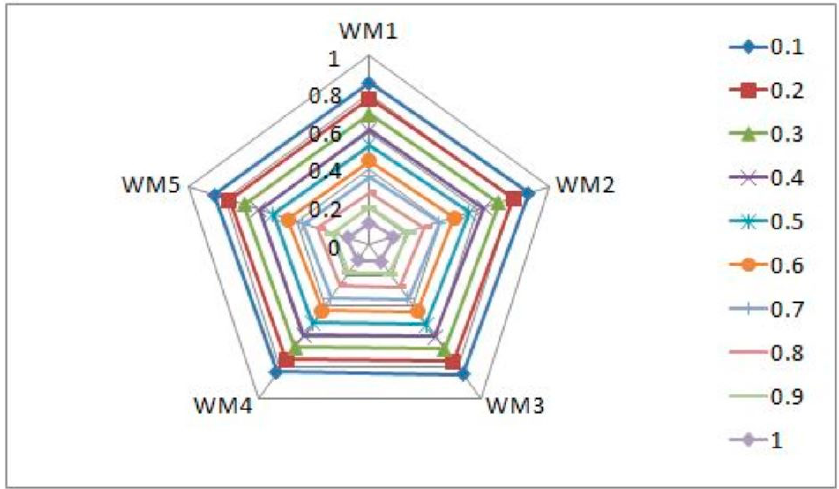
Figure 3. Sensitivity analysis of windmill suppliers for varying λ values.